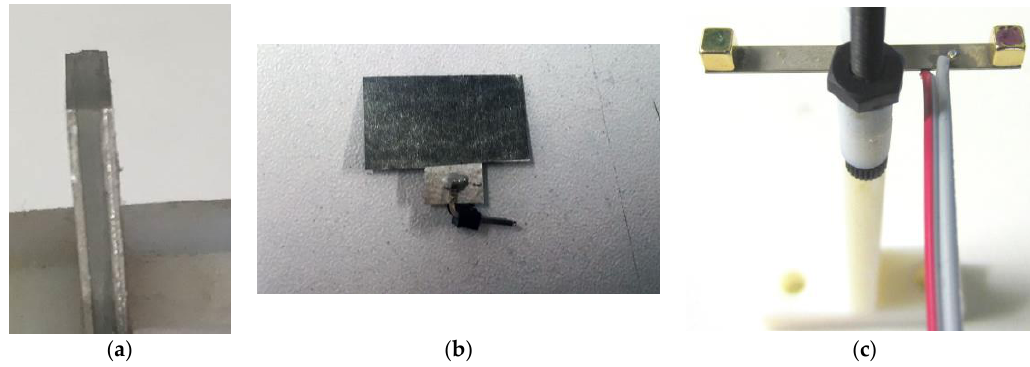
Figure 7. Images of fabricated test structures. ( a ) Galfenol-lead zirconate titanate (PZT) laminate. ( b ) Metglas-polyvinylidene fluoride (PVDF) ME laminate. ( c ) MME structure.